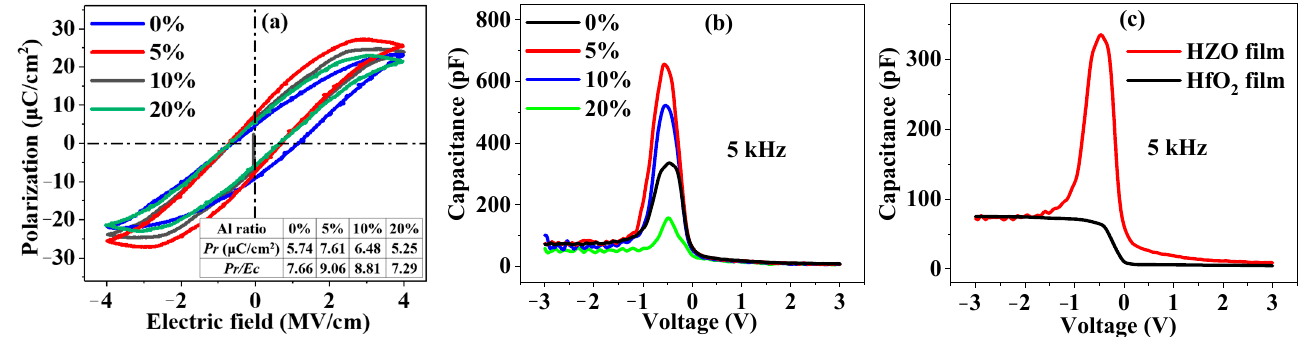
Figure 2. ( a ) P-E curves of HZAO thin films with different Al contents; ( b ) C-V curves of (Au/Cr)/HZAO/p ++ -Si capacitors with different Al contents at 5 kHz (annealing temperature: 650 °C); ( c ) C-V curves of (Au/Cr)/HZO/p ++ -Si and (Au/Cr)/HfO 2 /p ++ -Si and capacitors at 5 kHz (annealing temperature: 650 °C).